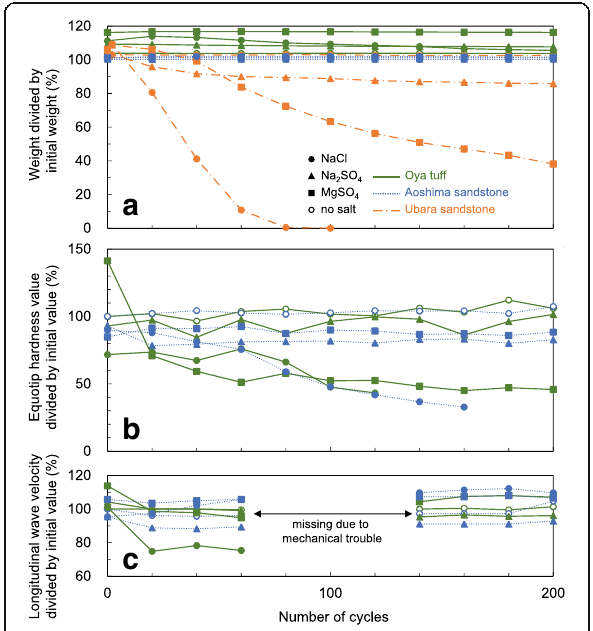
Fig. 5 Weight ( a ), Equotip rebound value ( b ), and longitudinal wave velocity ( c ) measured during the humidity-change experiment. All the measured values are divided by the initial value measured before the specimens were immersed in the salt solutions. Records of longitudinal wave velocity from 80 to 120 cycles went missing because of mechanical trouble. The solid line, dotted line, and dashed line represent the results for Oya tuff, Aoshima sandstone, and Ubara sandstone, respectively. The symbols correspond to the following combinations: filled circles, NaCl; triangles, Na 2 SO 4 ; squares, MgSO 4 ; open circles, no salt (distilled